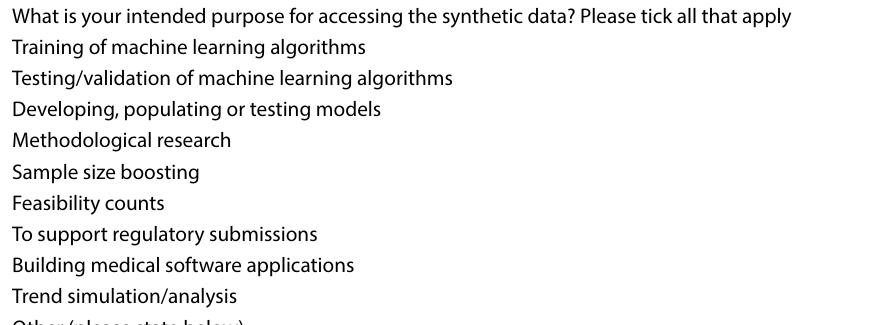
Table 2 Suggested purpose for use of synthetic data from request form used by MHRA- CPRD database